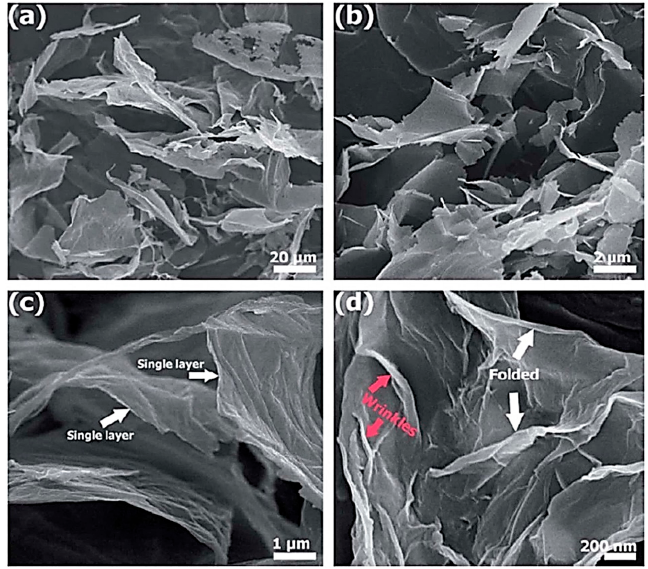
Figure 6. FESEM micrographs of multilayer Gp at ( a ) low, ( b , c ) moderate, and ( d ) high magnification. Reprinted with permission from [67]. Copyright Elsevier, 2013.